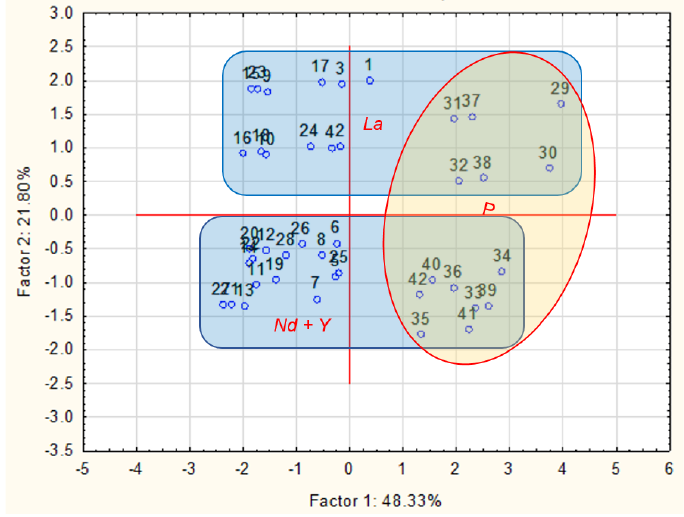
Figure 3. Projection of the scores on PC1 and PC2 plane. Several major and smaller clusters can be found.